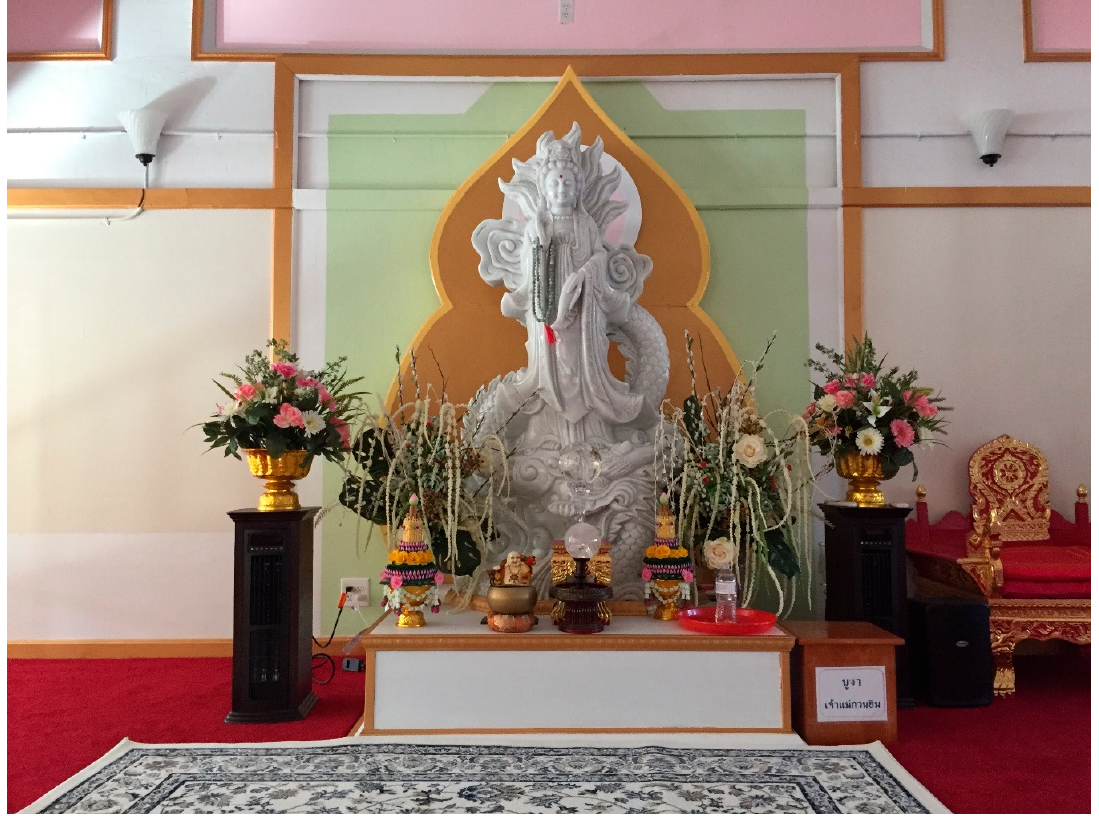
Figure 1. Avalokite ś vara (Th. Kuan Im), the savior-bodhisattva associated with compassion, at Wat Mongkoltepmunee (Bensalem, PA). Source: www.jivaka.net. All photos in this article were taken by